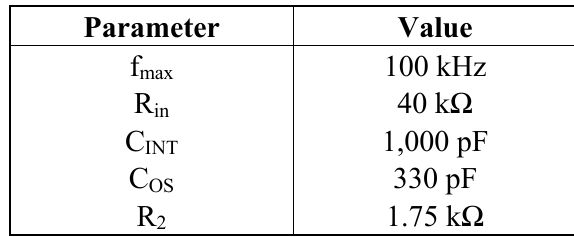
Table 4. Parameters of the voltage-to-frequency